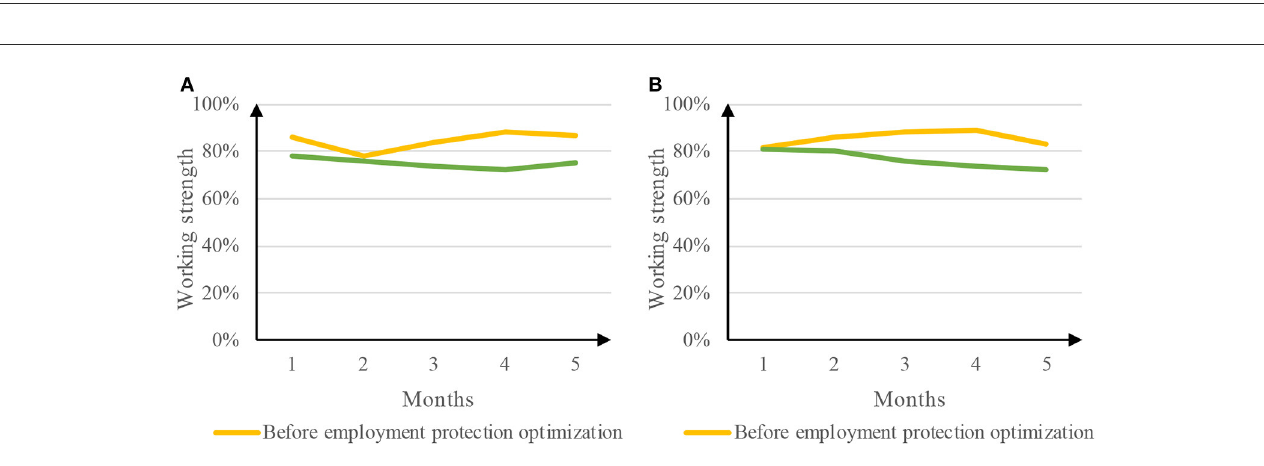
FIGURE7 Comparison results of work intensity. (A) Work intensity of Meituan takeout. (B) Work intensity of ELEME